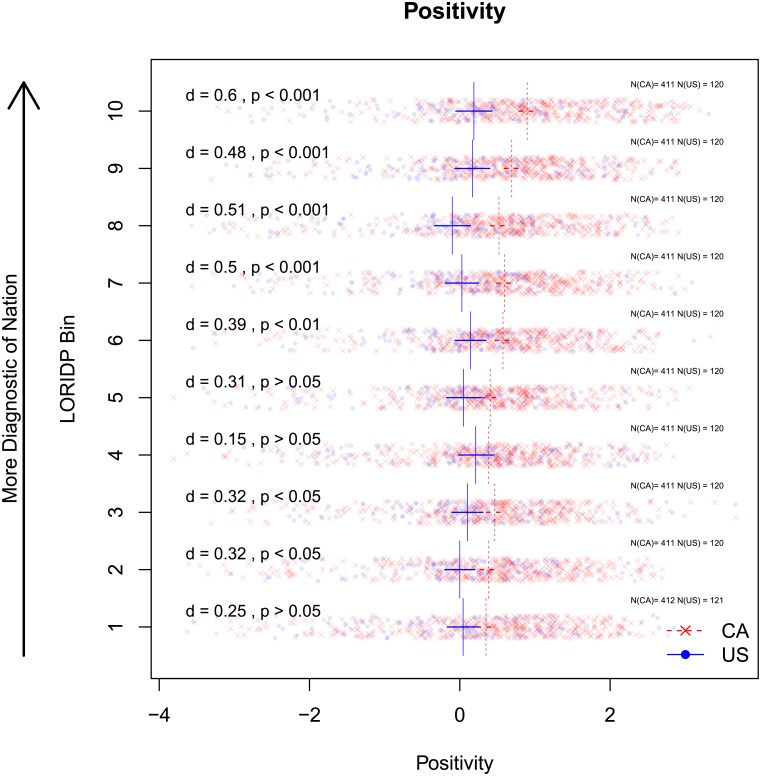
Positivity of Canadian and American words by LORIDP bin.Relative Positivity of very American (blue) versus very Canadian (red) words. Vertical lines indicate mean positivity of American and Canadian words in each bin. Horizontal lines are 95% confidence intervals of the means. Cohen’s d and p-values for t-tests within each bin are reported in the left of the fig. Canadian words are generally more positive across the LORIDP distribution, with the greatest and most robust difference amongst the most nationally diagnostic words.